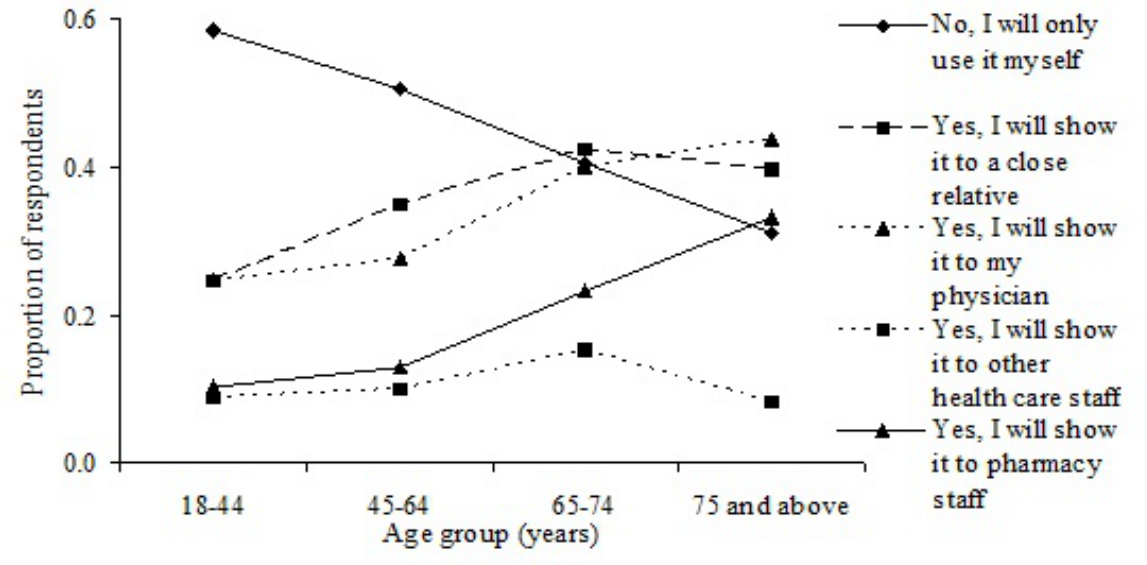
Figure 3. Frequency distribution of respondents’ answers to the question, “In the future, will you show or discuss your ‘My dispensed medications’ with another